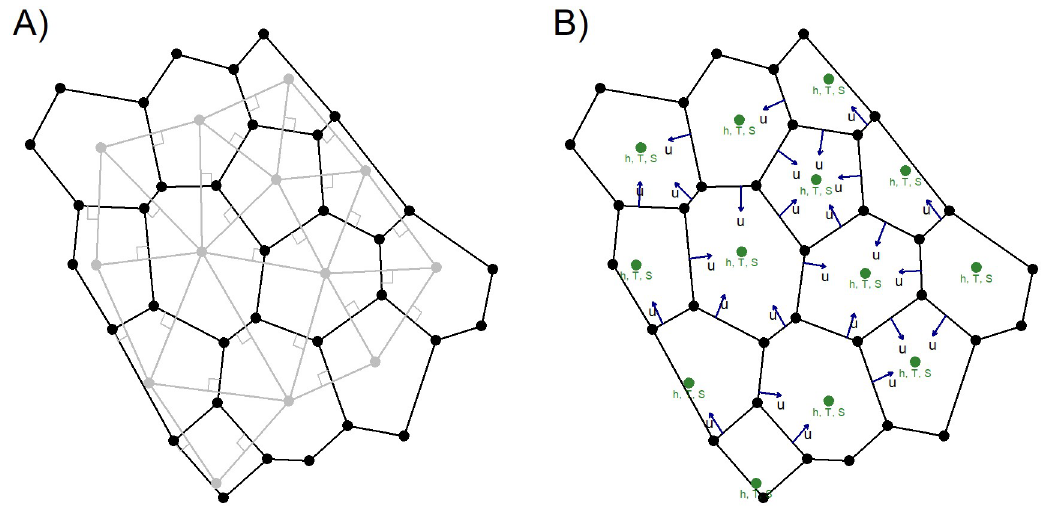
Fig 1. Computational mesh. A) An example of a 2D unstructured orthogonal mesh. Nodes in black, Voronoi points and perpendicular connecting lines (dual mesh) in grey. B) The staggering (C-grid) of the mesh: scalars are defined at the Voronoi points in the element/cell centers (finitie volume) and velocities on the dual mesh intersections points (finite difference). Velocities can be both positive and negative, thus representing any flux through the mesh.